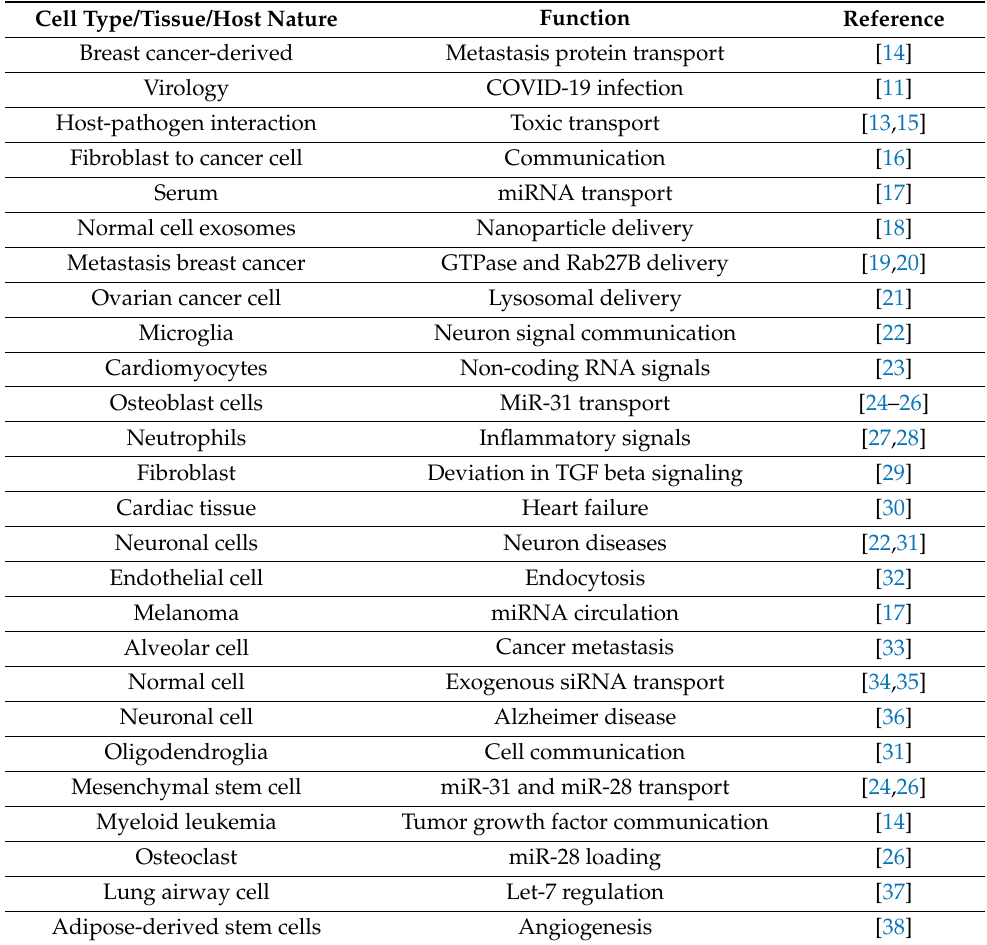
Table 1. Functions of